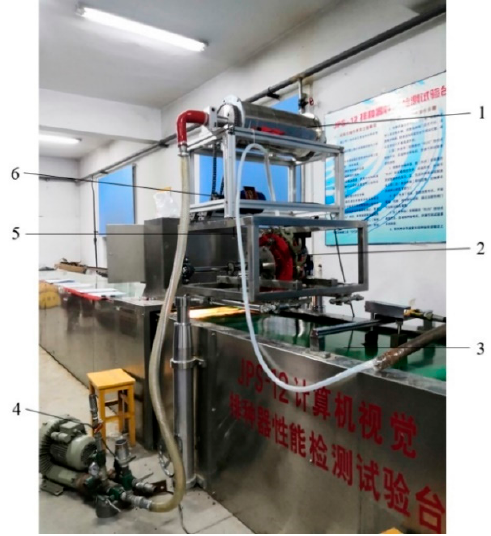
Figure 16. Bench test of a split seeding system. 1. Seed discharger; 2. Hole sower; 3. Seed belt; 4. High ‐ pressure whirlwind fans; 5. Positive pressure seed delivery tubes; 6. Gear